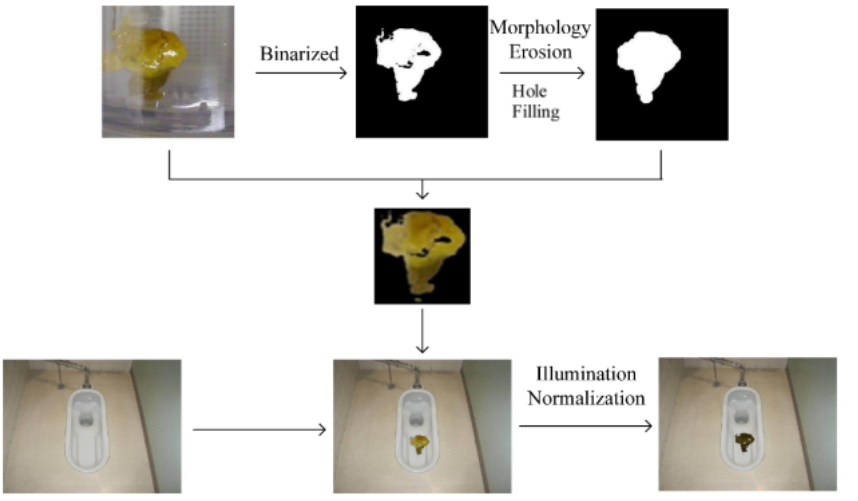
Figure 5. Process for synthesizing real-scene feces images.